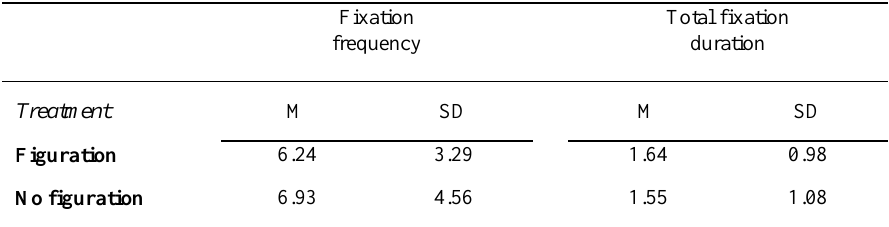
Table 4. Means (M) and Standard Deviation (SD) of Attention Measures for Brand Logo